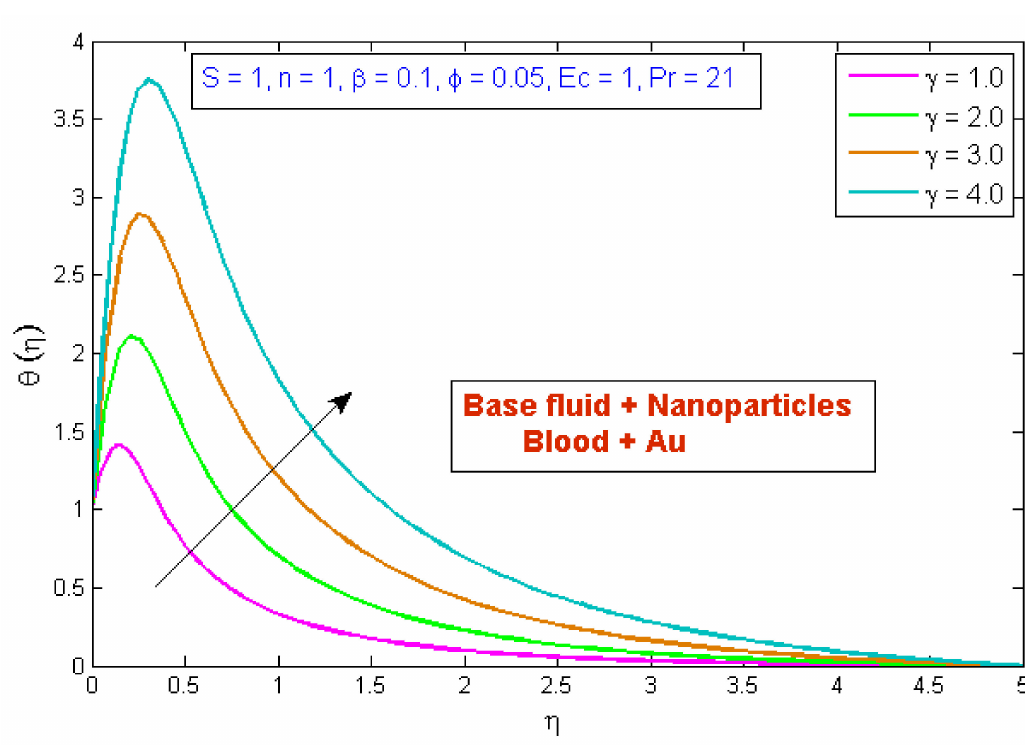
Figure 9. Modification of θ ( η ) versus γ